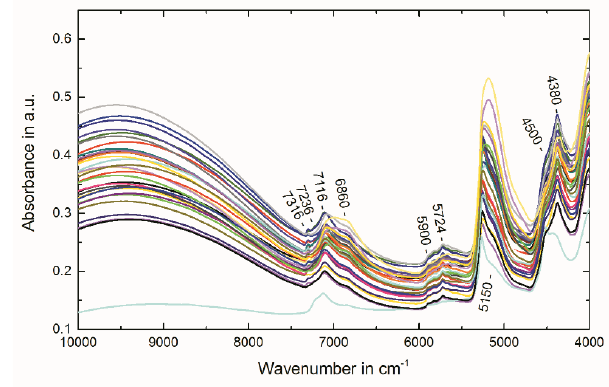
Figure 1. Raw NIR spectra of all 32 IMAC materials.